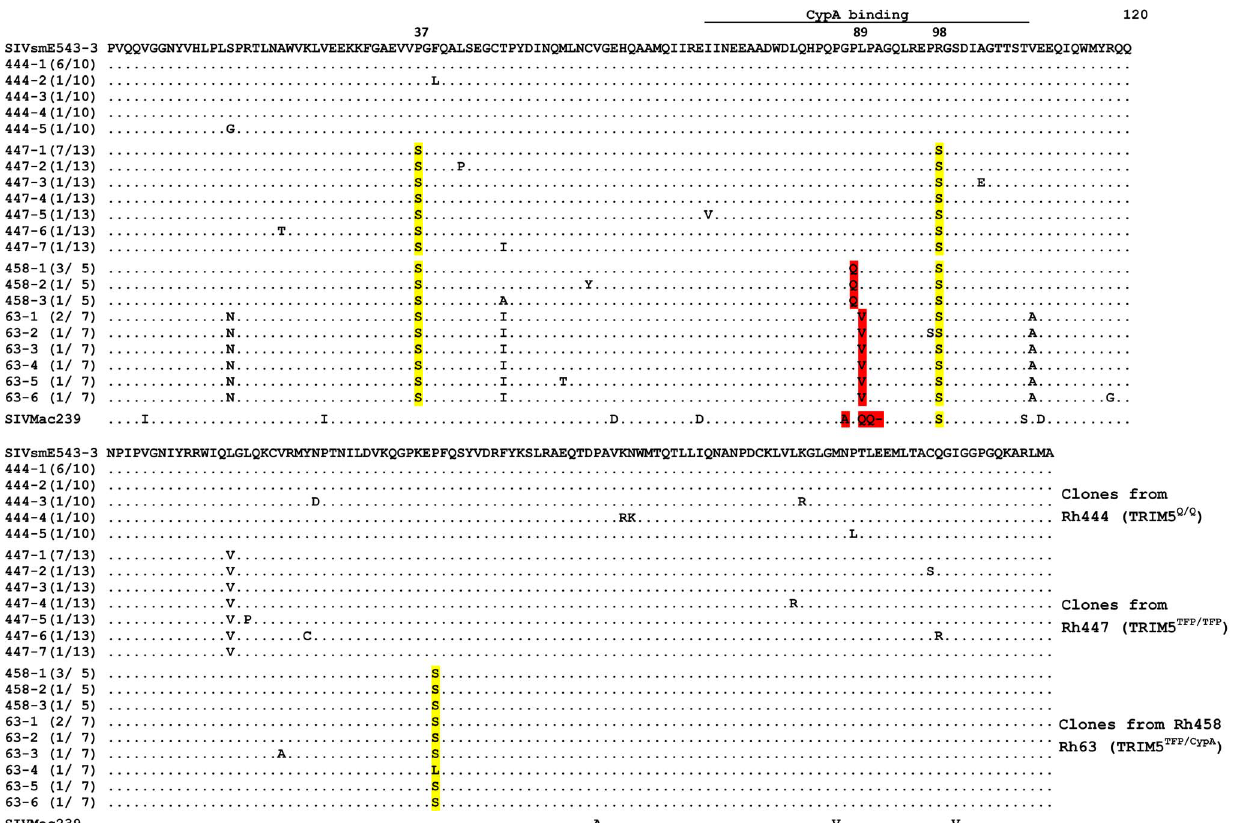
Figure 3. Identification of amino acid substitutions associated with escape from TRIM5 restriction. The capsid amino acids of SIV clones from Rh444 (TRIM5 Q/Q ), Rh447 (TRIM5 TFP/TFP ), Rh458 (TRIM5 TFP/CypA ) and Rh063 (TRIM5 TFP/CypA ) were aligned to parental SIVsmE543-3. Identical amino acids were shown as dot (.), deletions are shown as dash (-). Amino acid substitutions shared among SIV clones from different macaques were highlighted with yellow. Amino acid substitutions in the CypA binding loop are highlighted in red. The critical amino acid residues identified as responsible for escape from TRIM restriction are indicated by numbers above the sequence.